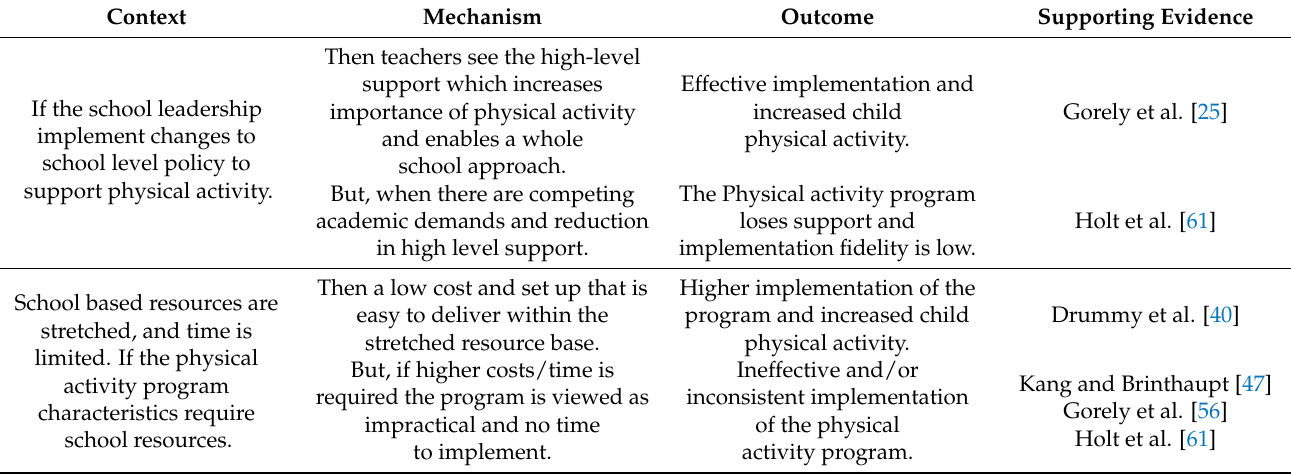
Table 3. Institutional level (school) of a conceptual framework for School-Based Physical Activity Interventions in Children Aged 7–11 Years of program theories